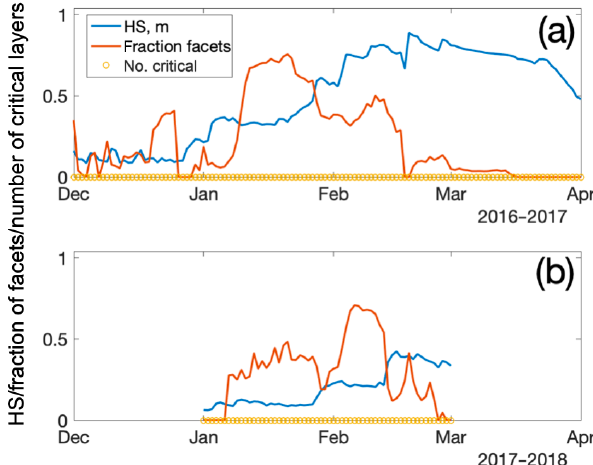
Figure 9. Stratigraphy summary of the AKAH stations for 2017 (a) and 2018 (b) . Plotted are the median values of the following: height of snow (HS), fraction of the snowpack containing facets, and num- ber of critical layers. The number of stations used to compute the medians varied due to snow